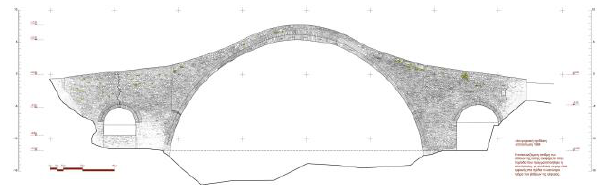
Figure 4. South façade plan of Plaka bridge before the collapse.